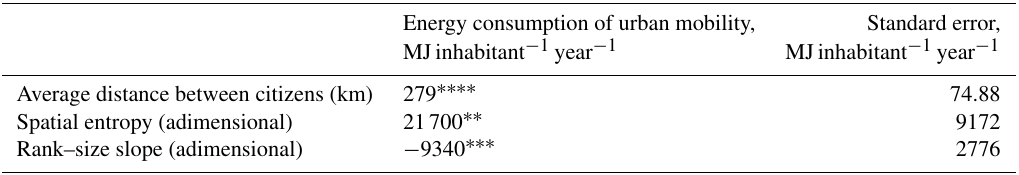
Table 1. Estimates of the urban-form-related determinants of energy consumption of urban mobility. Energy consumption of urban